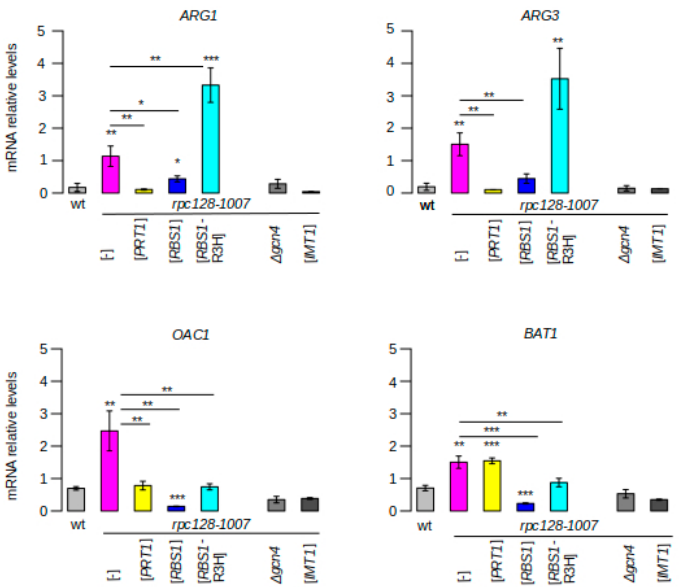
Figure 3. Induction of GCN4 expression in the Pol III assembly mutant is differentially affected by the suppressors RBS1 and PRT1 . RNAs that were isolated from the rpc128-1007 mutant, which was transformed with the indicated plasmids and control strains (wt, rpc128-1007 gcn4 ∆ ), were analyzed by RT-qPCR with specific probes ( n = 3). Values of p were calculated using a two-tailed paired t -test: * p < 0.05; ** p < 0.01; *** p < 0.001.